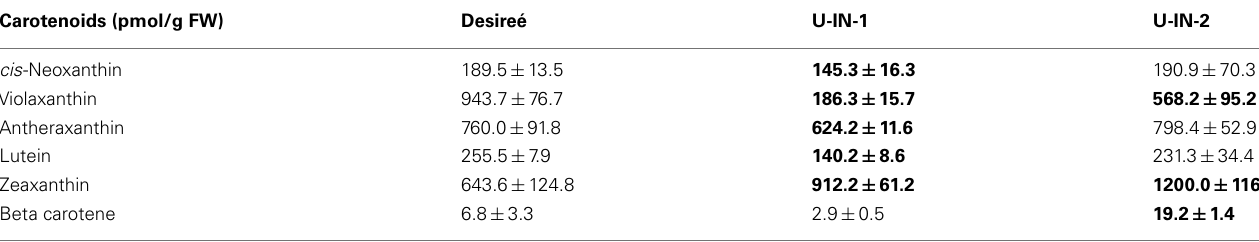
TableA4 | Carotenoid contents of the different genotypes. Carotenoids (pmol/g